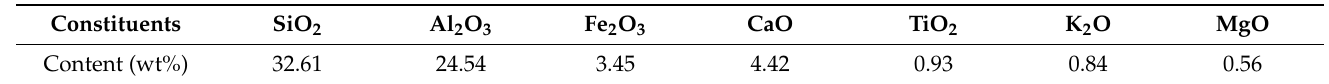
Table 2. Chemical composition of PFA.